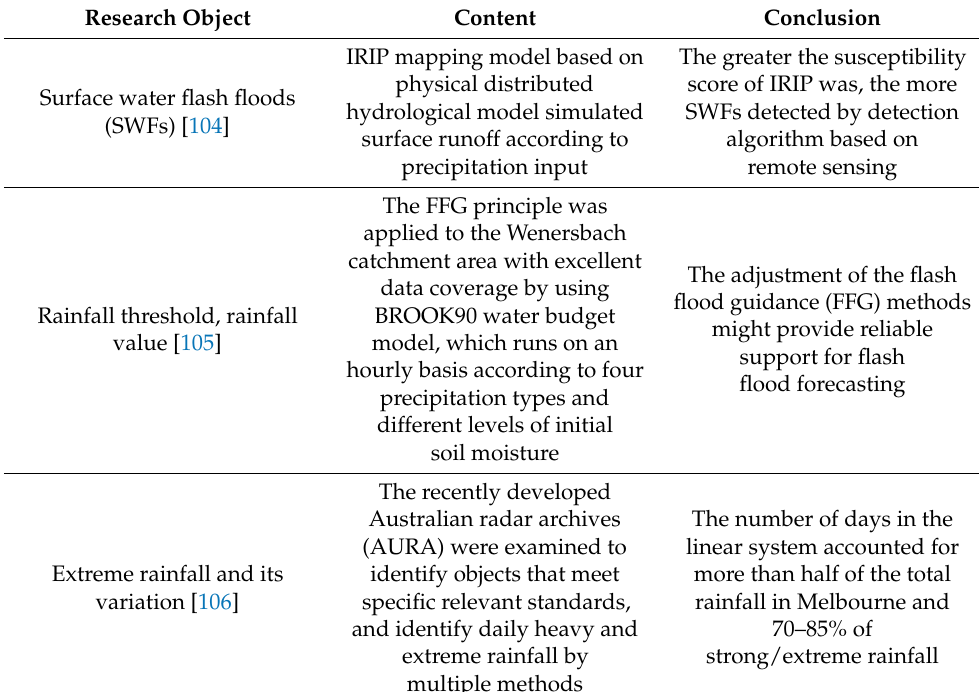
Table 4. Research Table 4. Research methods.